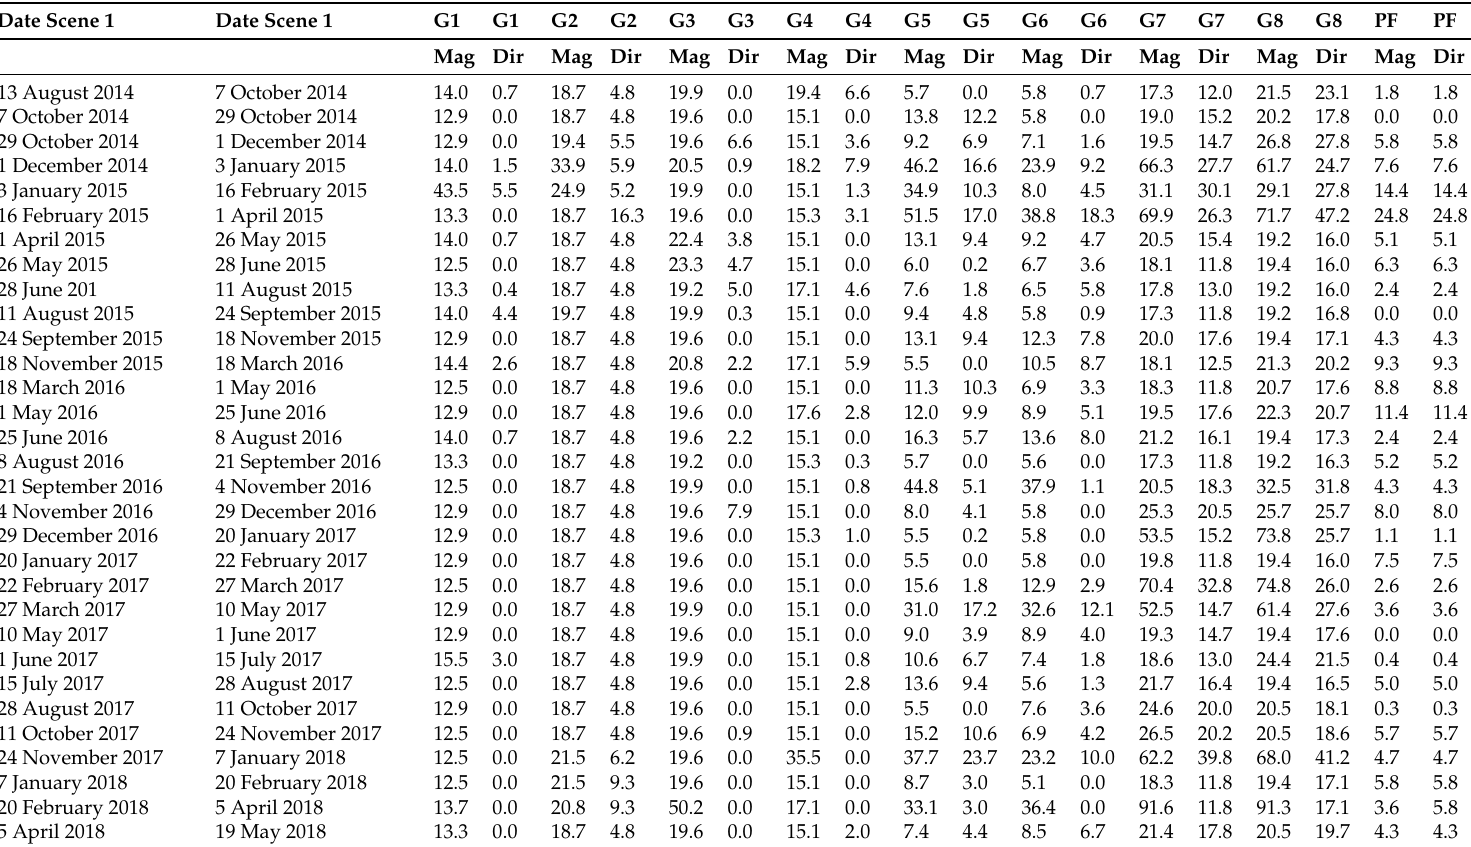
Table A3. Fraction of data gaps in % for the surface velocity magnitude (Mag) and direction (Dir) measurements along each flux gate. Relatively constant values such as for G1–G4 are a sign of missing values at the southern glacier boundary where velocities and ice thickness are small, resulting in almost no influence on ice discharge. High variability such as especially for G7 and G8 is a sign of sporadic data gaps in areas with high velocity and ice thickness, resulting in a large influence on ice